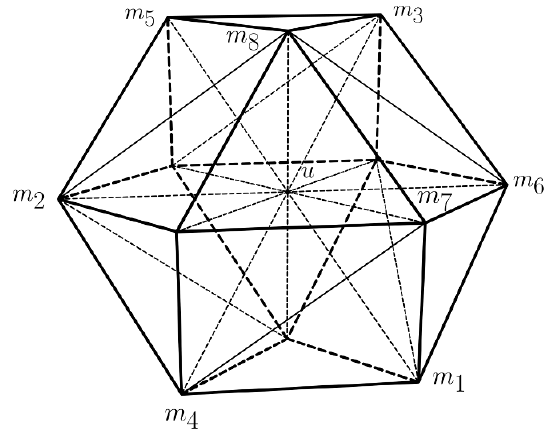
Figure 4 . Toric diagram for the three-loop banana